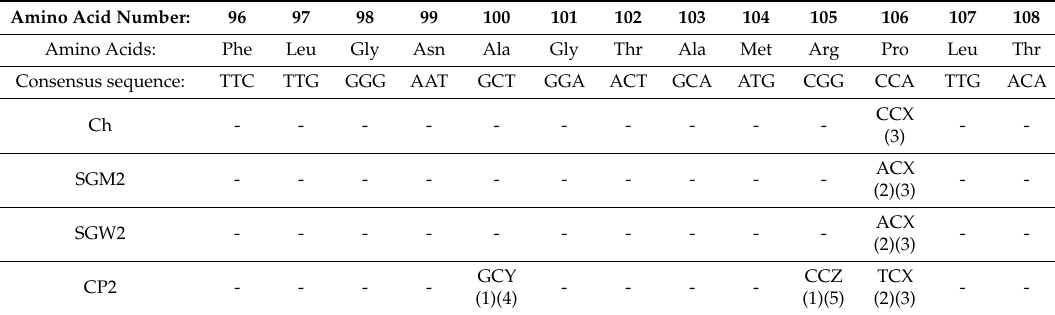
Table 5. Aligned nucleotide sequences of the conserved region of EPSPS for biotypes (Ch, SGM2, SGW2 and CP2) of Chloris virgata amino acids numbered according to Baerson et al., 2002 [28].